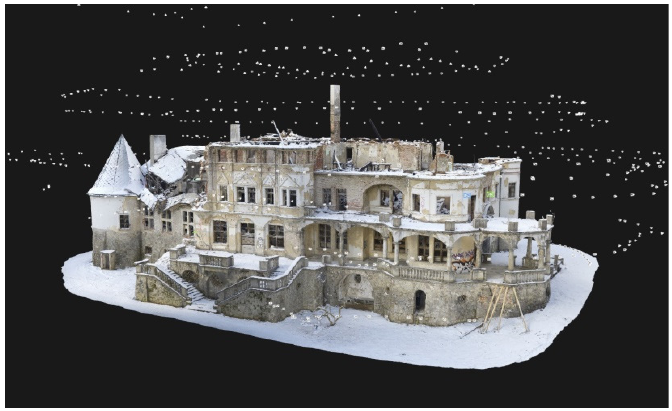
Figure 8. Aerial photogrammetry positions.